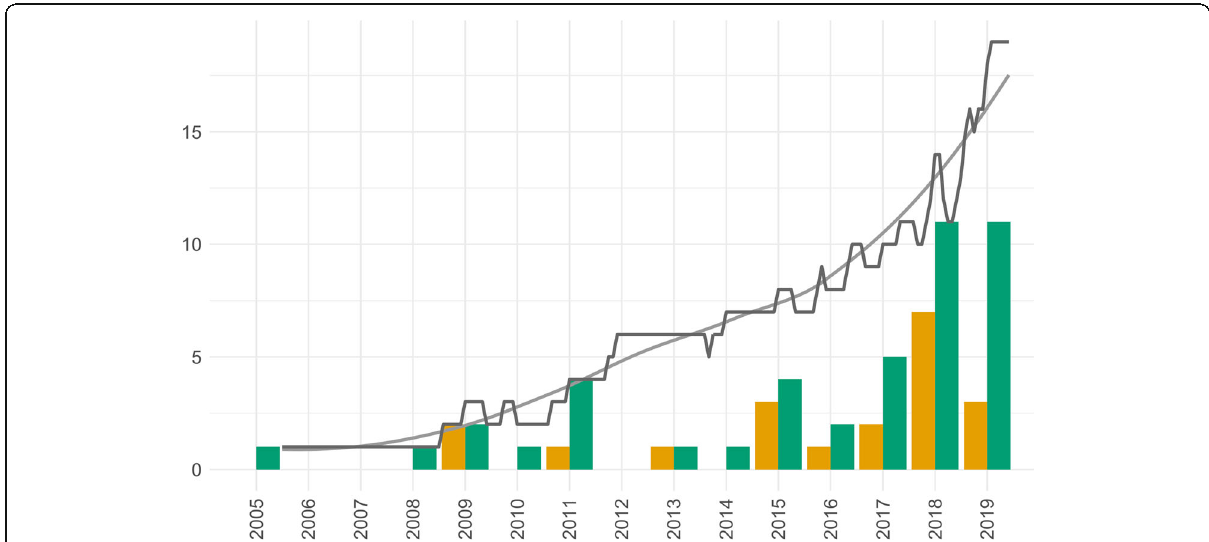
Fig. 1 Development of podcasts over time. The black line shows the total number of active podcast series ( y -axis) by year ( x -axis). The bar chart shows the number of podcast series started (green) and discontinued (orange) in each year. The graph shows that the total number of podcasts has risen steadily over the last 14 years, with a more rapid increase in the number of new podcasts over the last 2